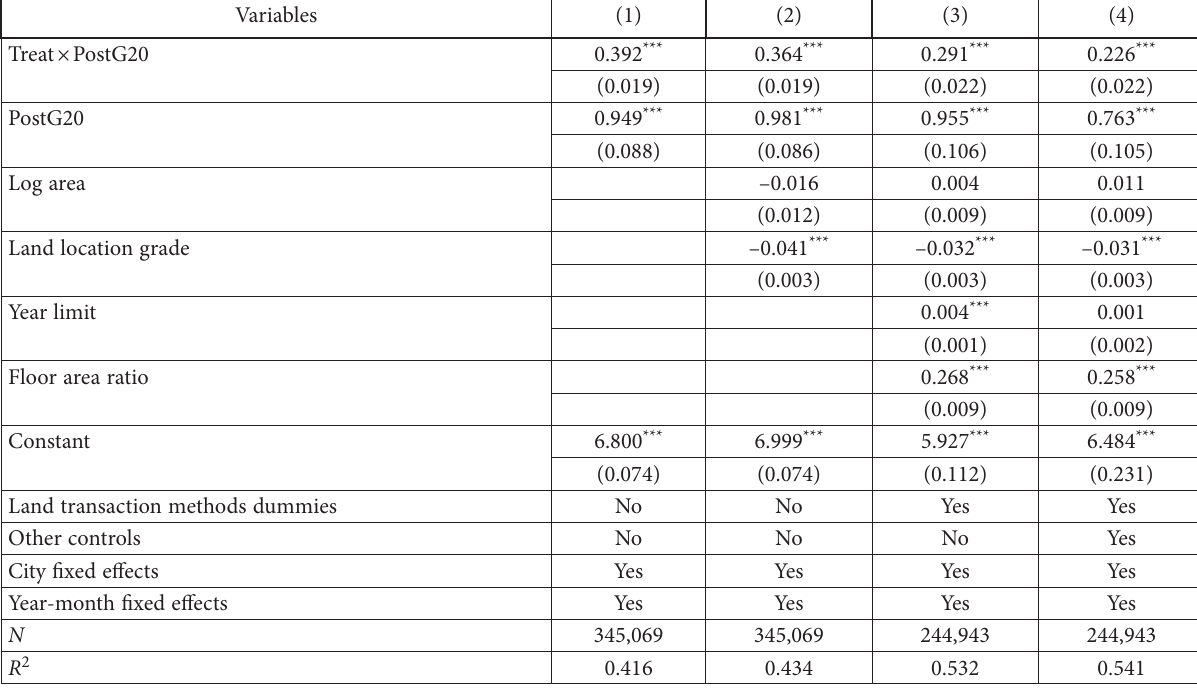
Table 2. The effect of hosting the G20 Summit on land